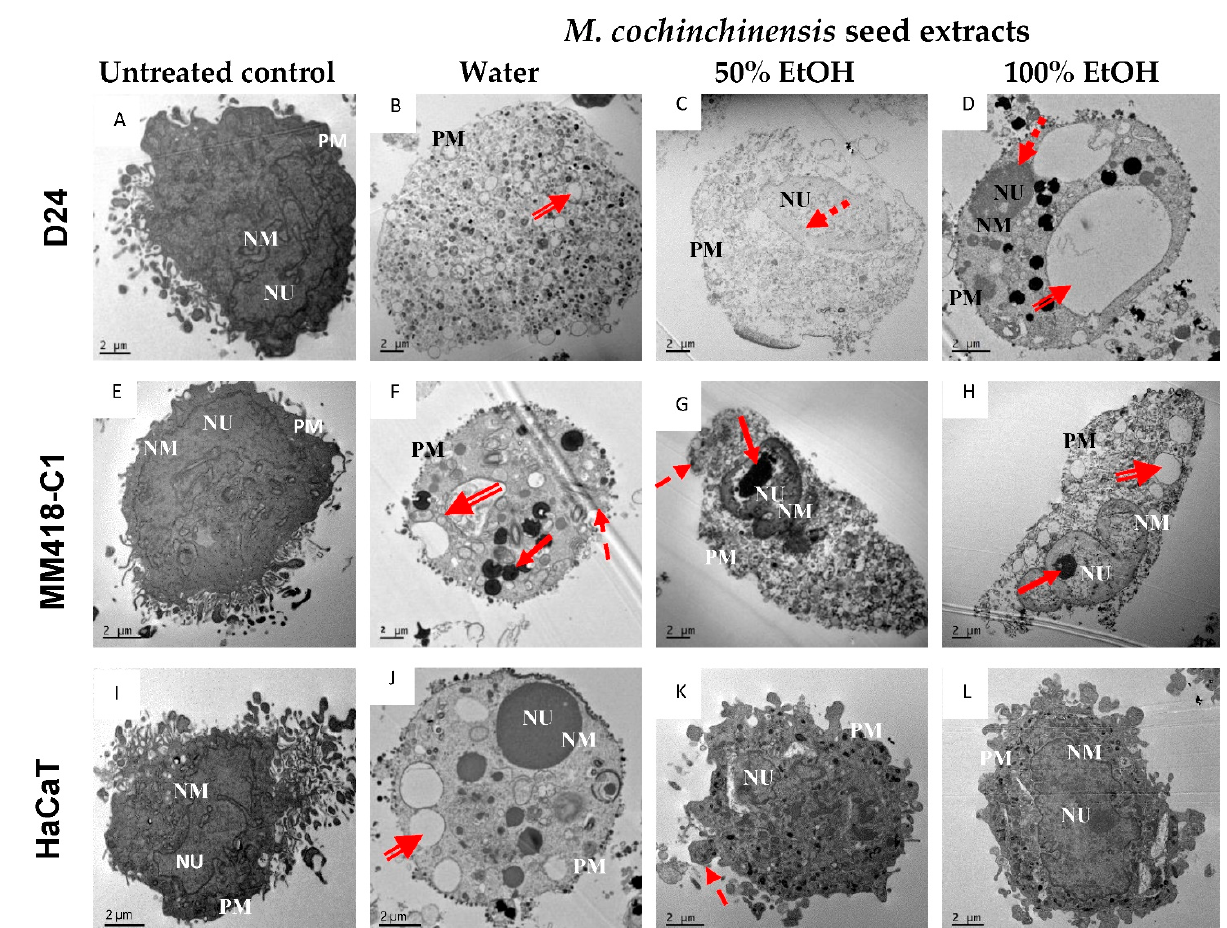
Figure 3. Effect of M. cochinchinensis seed extracts on the morphology of melanoma (D24 and MM418-C1) and HaCaT cells. The cells were treated with 100 µg/mL of the seed extracts for 48 h and examined under electron microscopy. Solid-line arrow: chromatin condensation, dotted-line arrow: margination of chromatin, hatched-line arrow: cell membrane blebbing, double-line arrow: vacuolisation, NU: nucleus, NM: nuclear membrane, PM: plasma membrane . A: Untreated D24 cells (control), B: D24 cells treated with water extract, C: D24 cells treated with 50% EtOH extract, D: D24 cells treated with 100% EtOH extract, E: Untreated MM418-C1 cells (control), F: MM418-C1 cells treated with water extract, G: MM418-C1 cells treated with 50% EtOH extract, H: MM418-C1 cells treated with 100% EtOH extract, I: Untreated HaCaT cells (control), J: HaCaT cells treated with water extract, K: HaCaT cells treated with 50% EtOH extract, L: HaCaT cells treated with 100% EtOH extract.